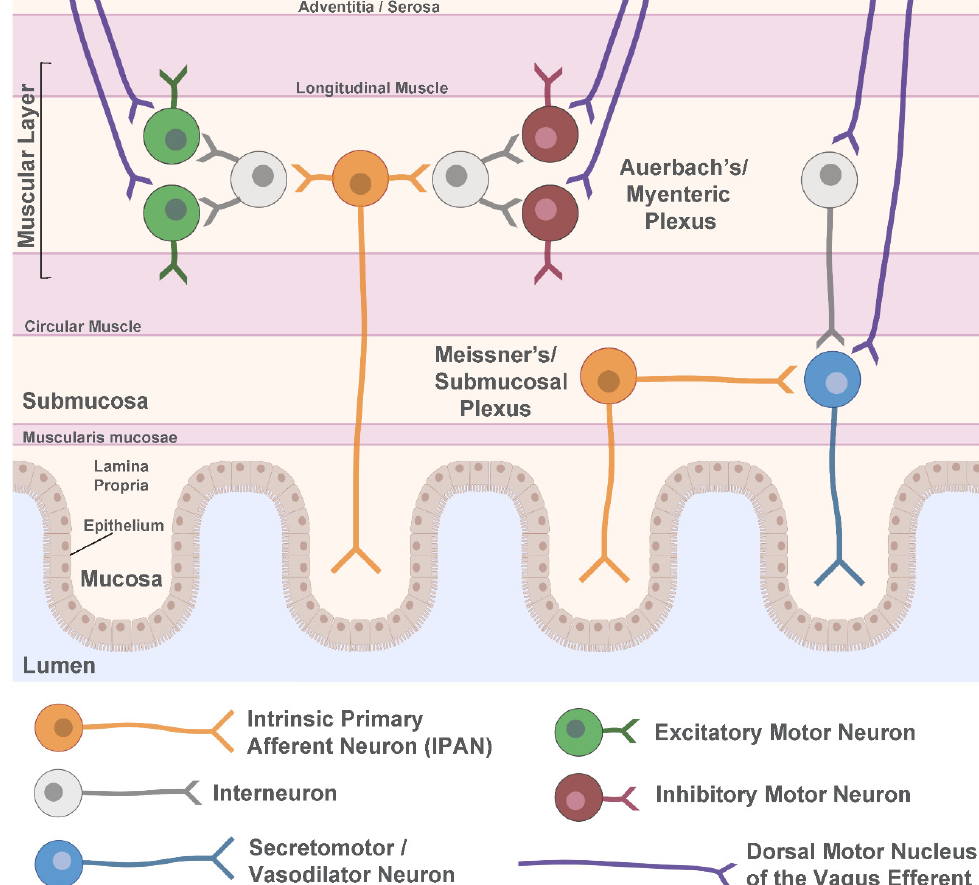
Figure 1. Schematic of the enteric nervous system. Shown are the major layers of the gastrointestinal wall with a simplified representation of neuronal circuitry. The myenteric (Auerbach’s) plexus con- tains motor circuits that control contraction and relaxation of the muscle layer whereas secretomotor and vasodilator neurons are primarily in the submucosal (Meissner’s) plexus and control local blood flow and secretion. Both plexuses receive extrinsic parasympathetic innervation from the dorsal motor nucleus of the vagus to help regulate gut motility. Sympathetic innervation and vagal sensory afferents are not shown. Figure created using